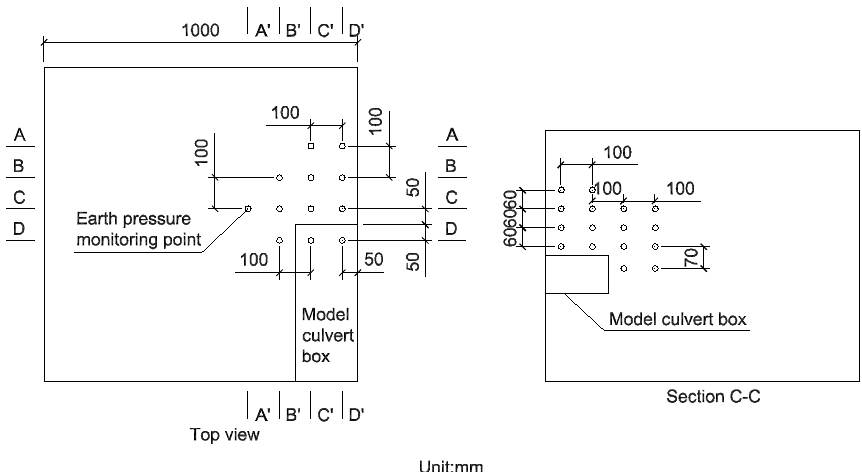
Figure 7. The layout diagram of the earth pressure monitoring point with a pipe